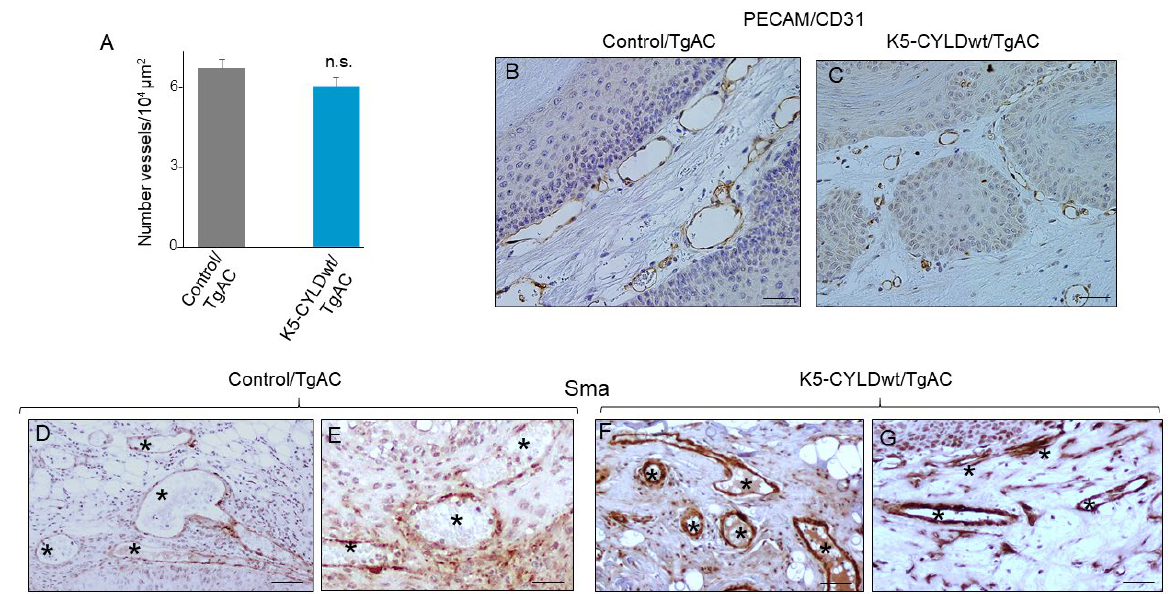
Figure 8. Smaller size and increased maturity of blood vessels in K5-CYLDwt/TgAC skin squamous cell tumors. ( A ) Graph showing the number of blood vessels/ µ m 2 found in Control/TgAC and K5-CYLDwt/TgAC tumors; no significant differences were detected. Data are shown as mean ± SEM by two-tailed t-test; n = 6 tumors/genotype; n.s.: statistically not significant. ( B , C ) Representative images of the immunostaining with PECAM (CD31) antibody showing the network of blood vessels in Control/TgAC and K5-CYLDwt/TgAC tumors. Observe the presence of lacunar vessels of large diameter in Control/TgAC tumors ( B ) versus vessels of small diameter in K5-CYLDwt/TgAC tumors ( C ). (D – G ) Immunohistochemistry with an anti-Sma antibody reveals a weak and discontinuous staining of blood vessels in Control/TgAC tumors ( D , E ), versus a strong and continuous staining in vessels of K5-CYLDwt/TgAC tumors ( F , G ). Scale bars : 40 µm ( B – C ); 20 µm ( D – G ). The symbol (*) indicates the light of the blood vessels in ( D – G ).